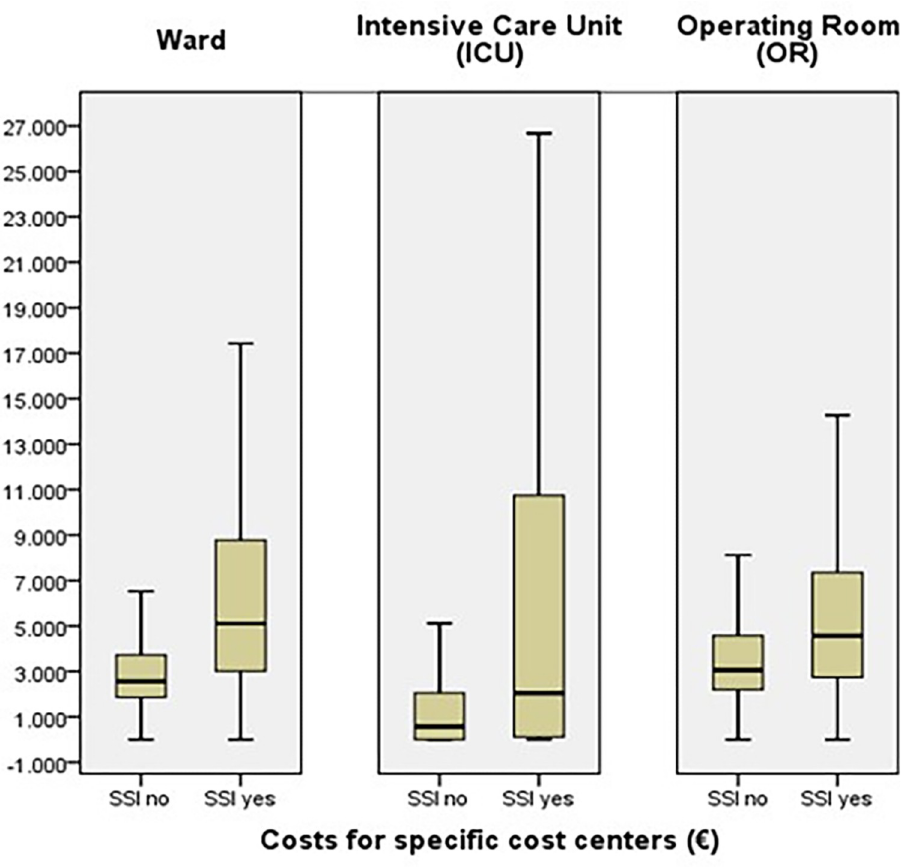
Fig 3. Median costs for SSI and non-SSI groups in specific cost